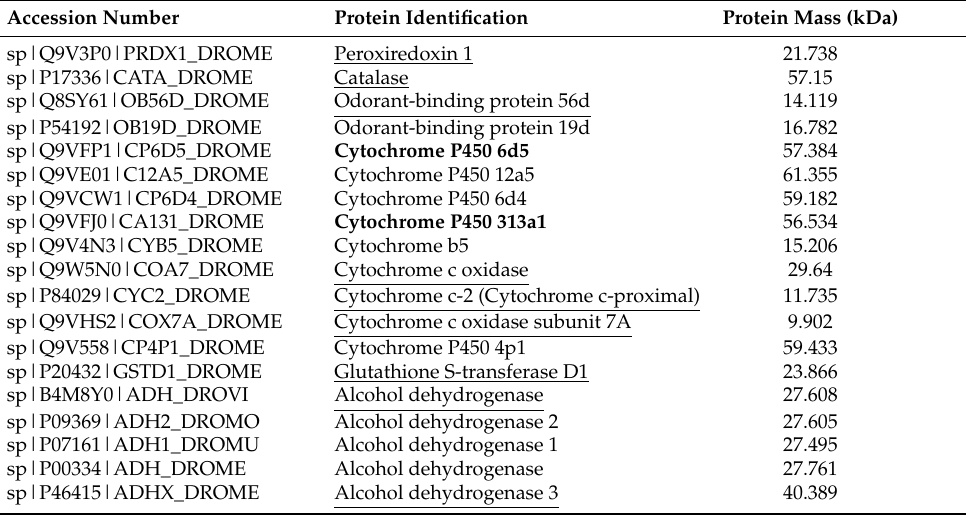
* Underlined entries designate an expression at least two times more important in females than in males; bold font indicates an expression at least two times more important in males than in